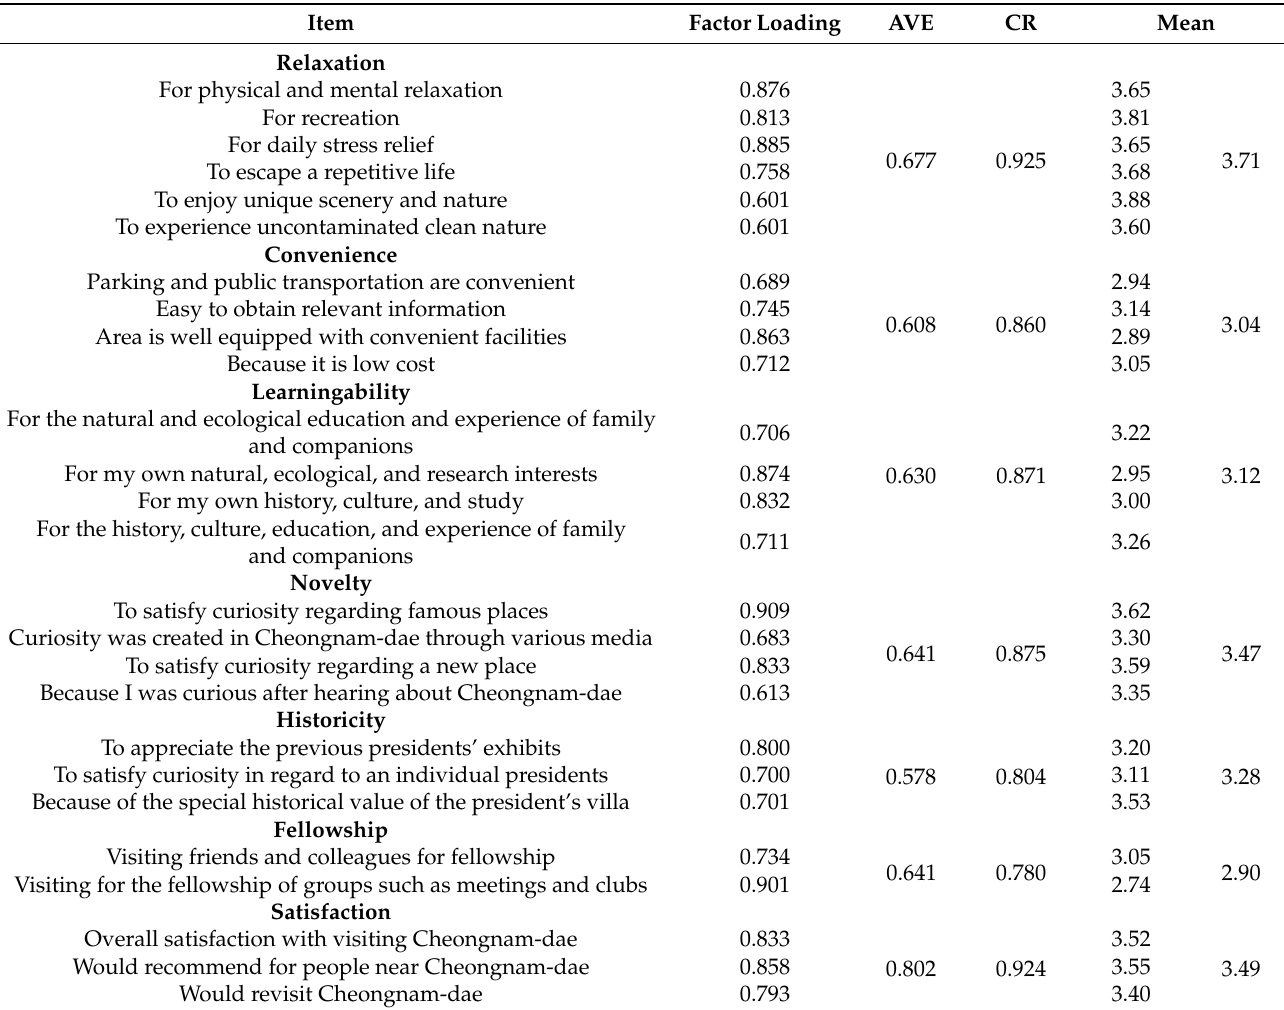
Table 3. Results of confirmatory factor